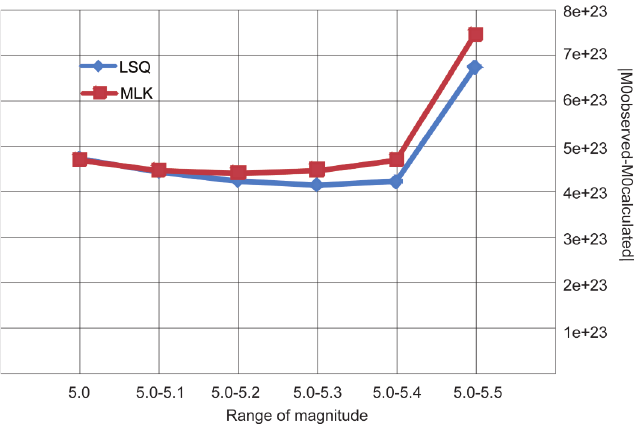
Figure 3. Differences between the observed cumulative moments from the instrumental catalog [CSTI Working Group 2001] and the calculated cumulative moments using G-R relationships with two different interpolation algorithms (LSQ, least square method; MLK, maximum likelihood method); six magnitude intervals are plotted, with increasing upper boundary limit.